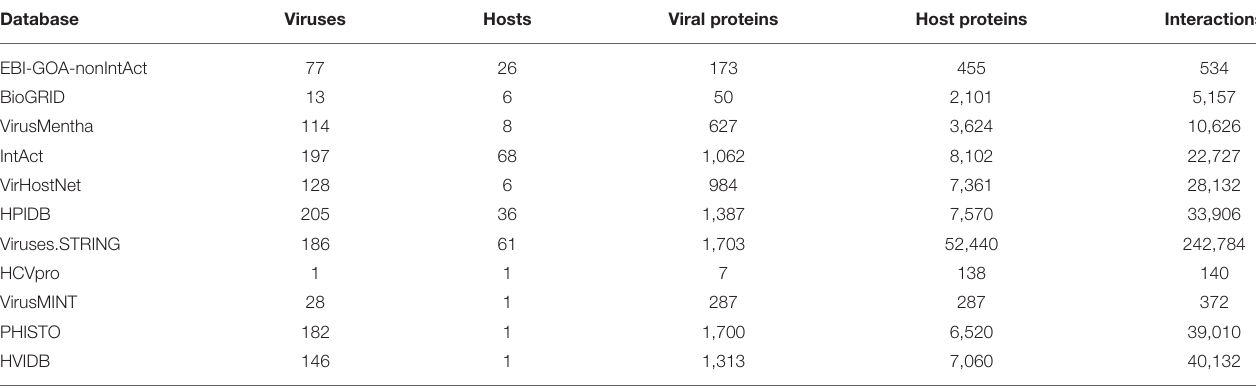
TABLE 1 | Virus-host protein–protein interaction datasets with UniProtKB-AC unique identifiers. Database